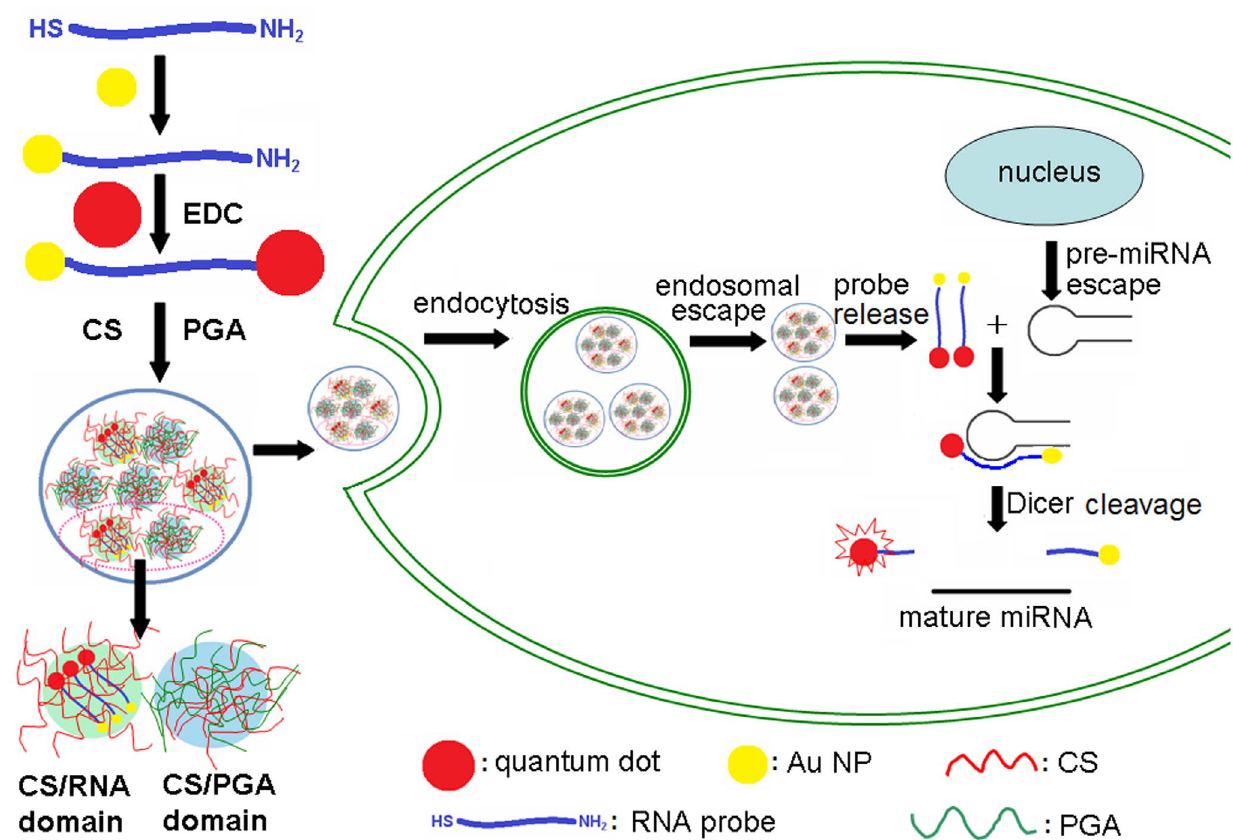
Figure 1. Transfection of QD-RNA-Au NP probe into cell via CS/ c -PGA complex for imaging of intracellular pre-miRNA.